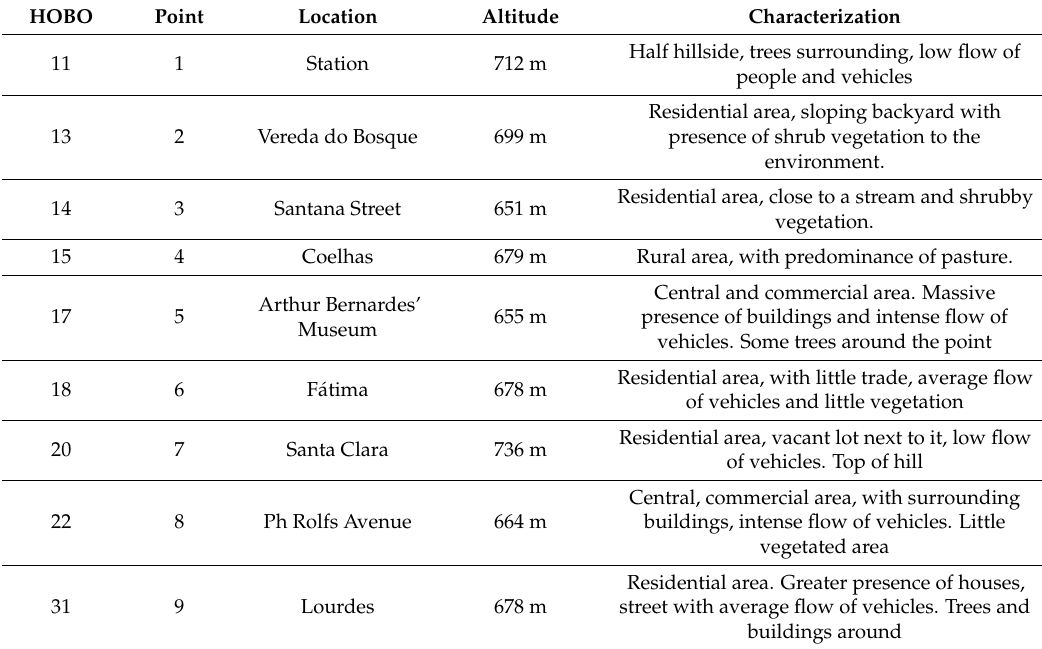
Table 1. Characterization of the surrounding collection points in